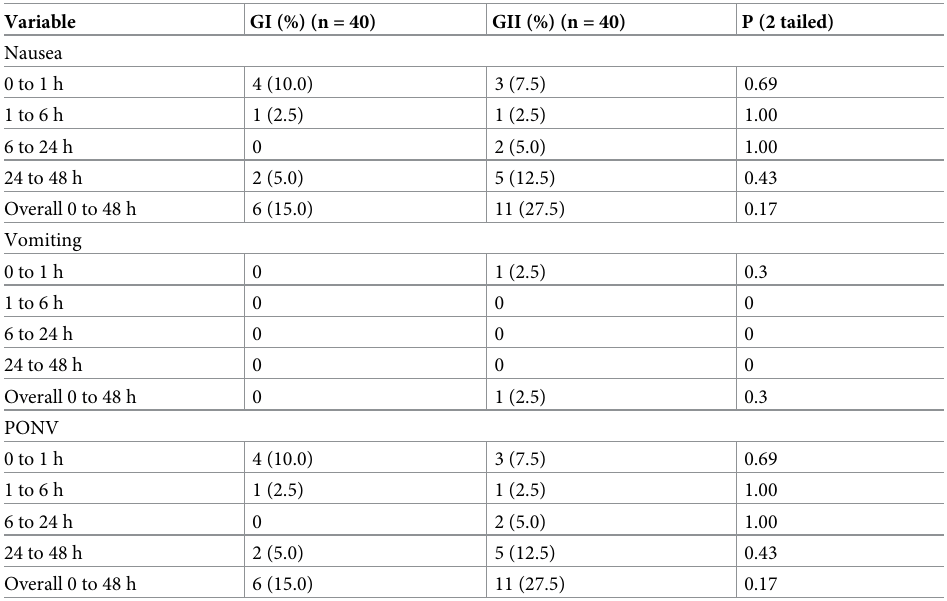
Data are the numbers (%). GI: palonosetron 1 μ g kg -1 ; GII: palonosetron 75 μ g; PONV: postoperative nausea and vomiting; % percentage. The statistical calculator MedCal was used using GI and GII and corresponding sample size